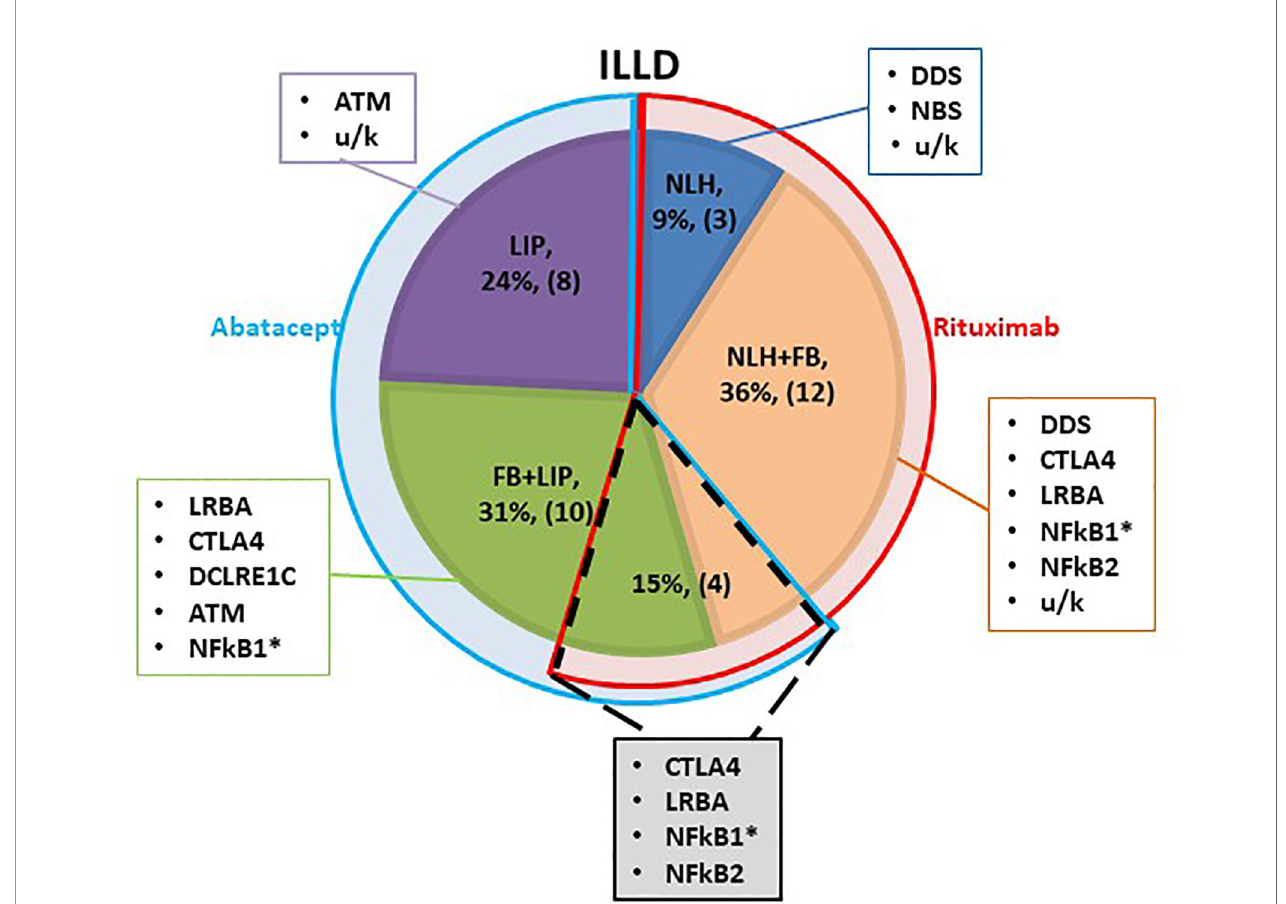
FIGURE 1 | Schematic characterization of the ILLD patient groups. Shaded segments represent different histological types of ILLD, with genetic PID defects noted in corresponding rectangles. Blue semi-ring denotes patients treated with abatacept, red - with rituximab. Overlapping segment (dotted line) denotes patients who were treated with rituximab, and later with abatacept. * - biopsy was performed